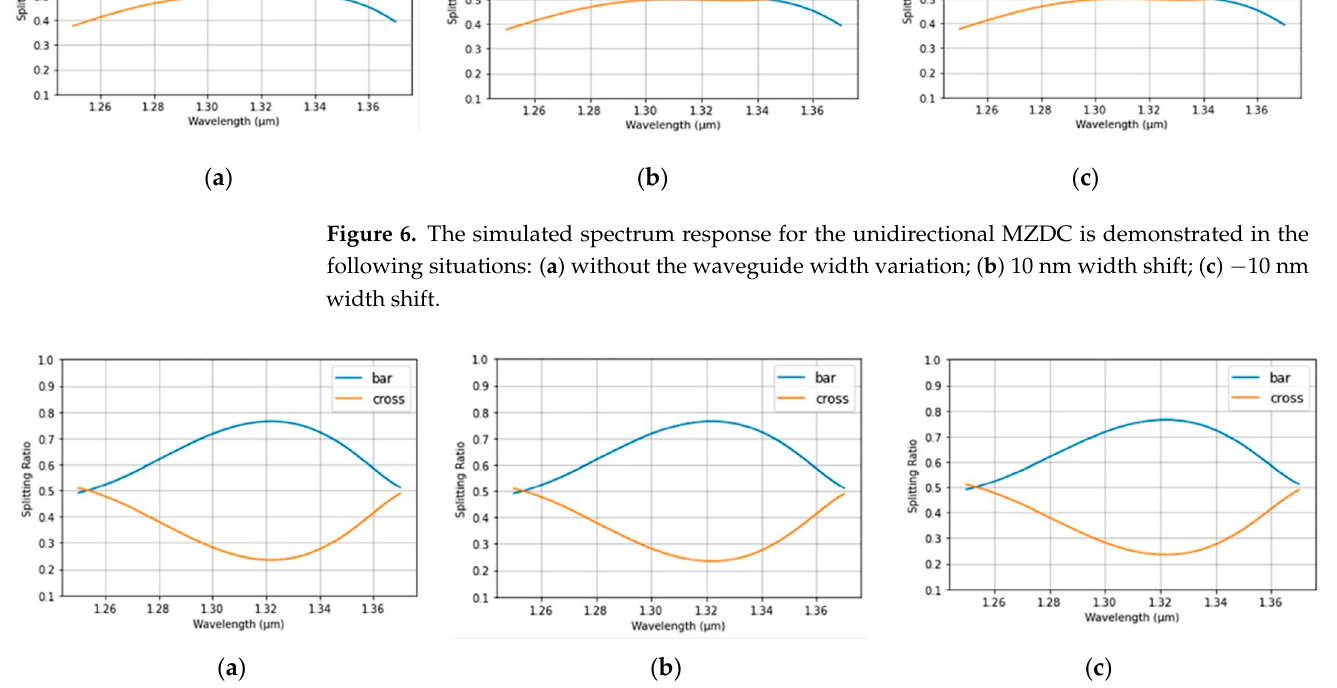
Figure 6. The simulated spectrum response for the unidirectional MZDC is demonstrated in the following situations: ( a ) without the waveguide width variation; ( b ) 10 nm width shift; ( c ) -10 nm width shift.